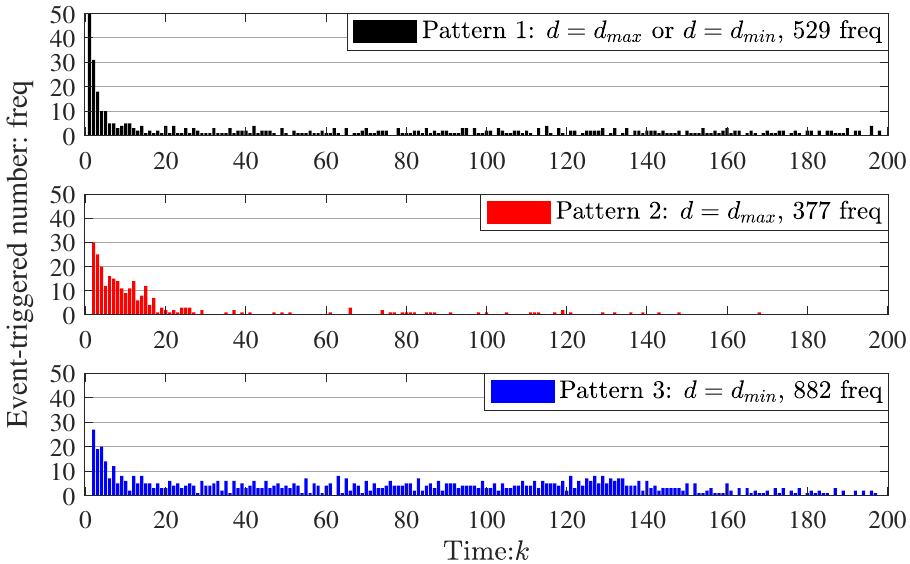
Figure 8. The event-triggered frequency of the node at every time k .